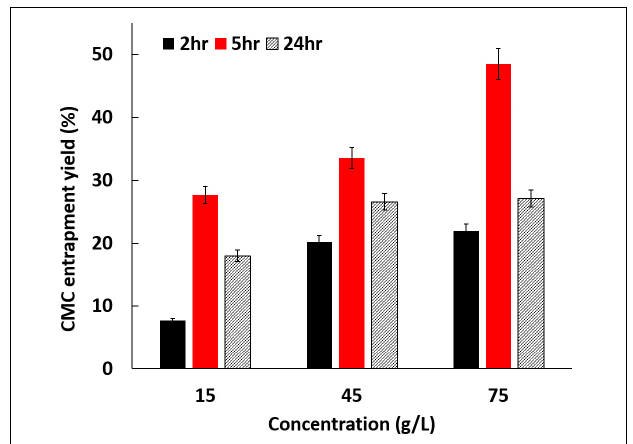
FIGURE 1 | Entrapment yield (%) of CMC inside